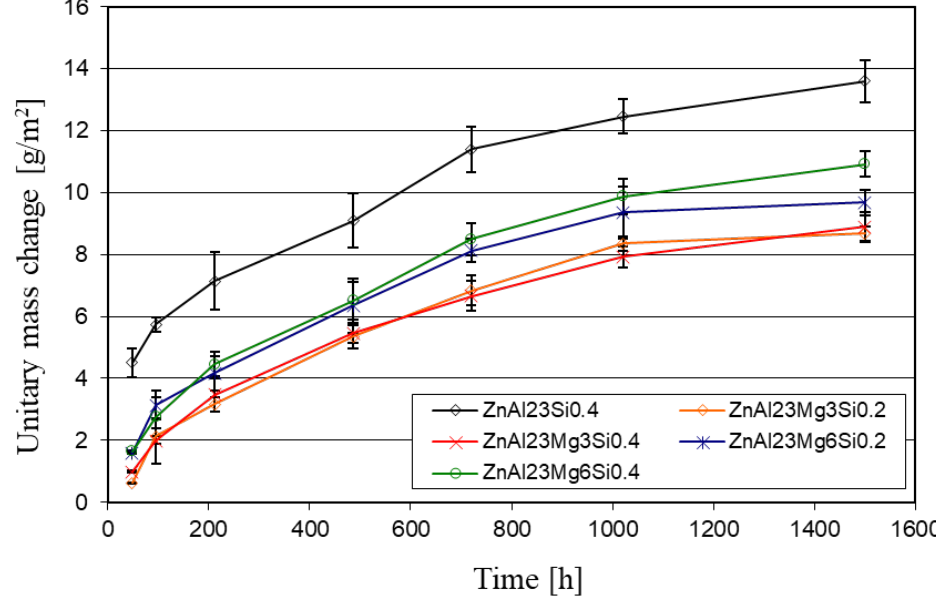
Figure 8. Dependence of unitary changes in the mass of coatings obtained in the research baths during the neutral salt spray test.